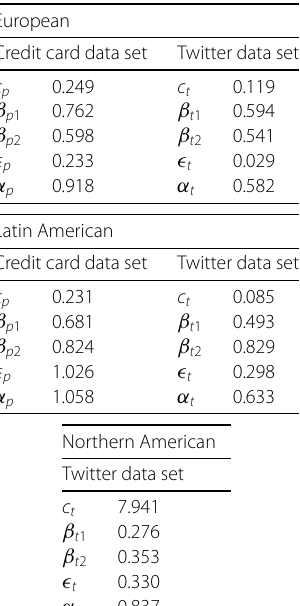
Table 1 Model parameters obtained by an OLS fitting, for (Top) European metropolitan area, (Middle) Latin American metropolitan area, and (Bottom) Northern American metropolitan area European Credit card data